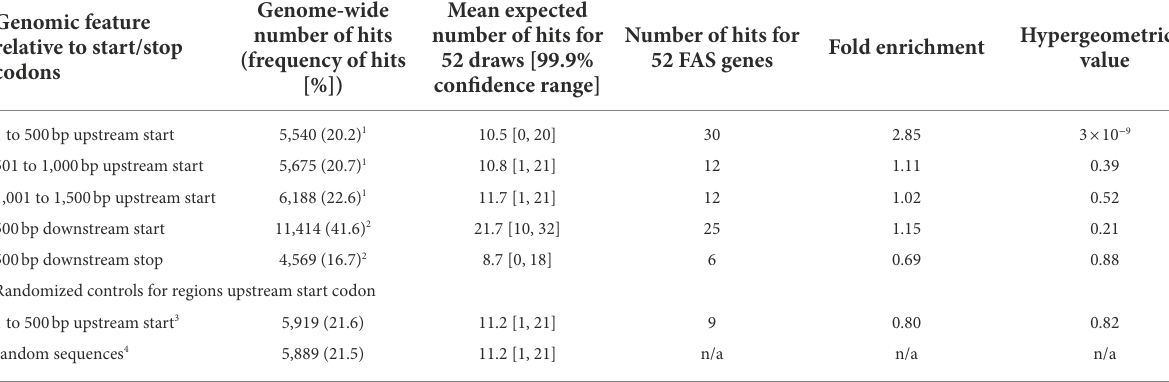
TABLE 1 Enrichment of the AW-box in genomic features of genes encoding for fatty acid biosynthesis in Arabidopsis thaliana. Genomic feature relative to start/stop